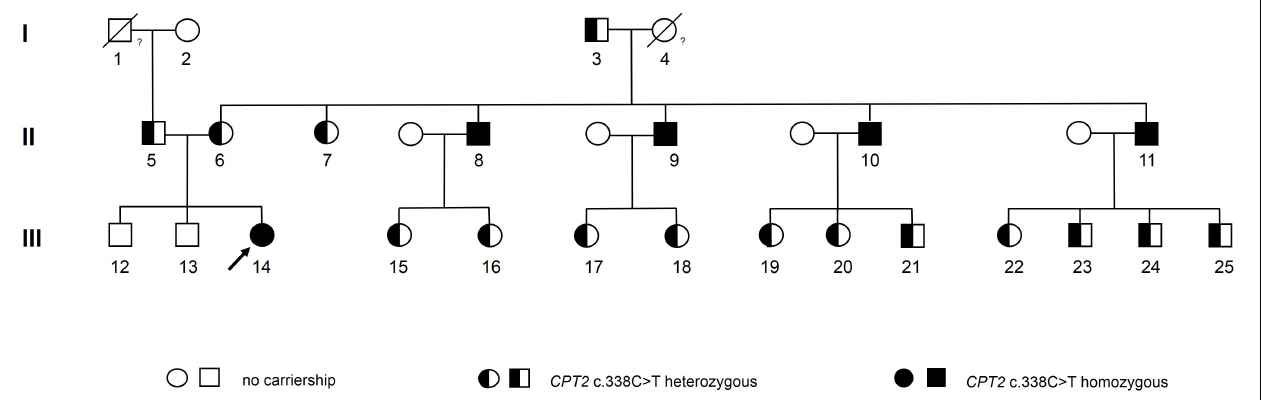
FIGURE 1 | Pedigree of an Austrian family with frequent occurrence of CPT II deficiency caused by the CPT2 c.338C > T mutation. The index patient is marked with an arrow. Genotypes of the deceased participants 1 and 4 may be assumed as heterozygous and homozygous, respectively, based on reported symptoms and statistical considerations (as given in the Supplementary Material